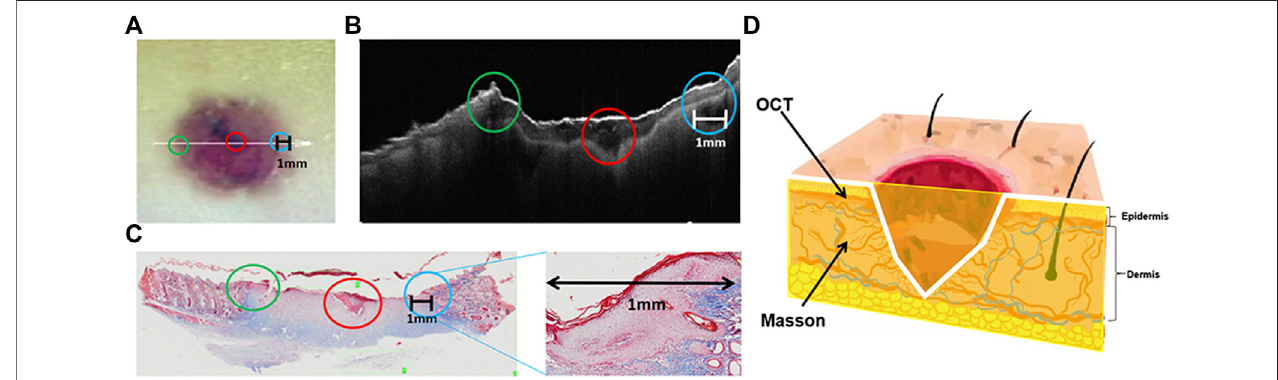
FIGURE7| Observationofthelongitudinalplaneofthewoundontheskin. (A) Imageoftheskinwound(thegreencirclemarkedtheleftwoundedge,thebluecircle marked the right wound edge, the red circle marked the wound center, and the white line marked the length range of the skin wound). (B) OCT image of the longitudinal plane of the skin wound (the green, red, and blue circles are marked with the same content as A). (C) Masson staining of the skin wound and enlarged view of the blue circle(green,red,andbluecirclescorrespond tothoseinAandB;theblacklinemarksthemigrationlengthrangeofepidermalcells). (D) Three-dimensionalsketch of the wound (the yellow section is the observation plane, the white line is the observation area, and the black arrow-pointed direction corresponds to the various observation methods and results, respectively).